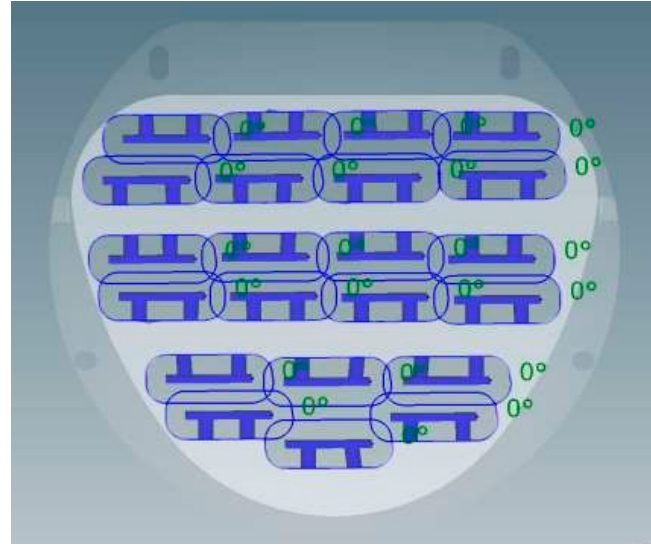
Figure 2. Design nested onto 16 mm Ceramill zirconia blanks.